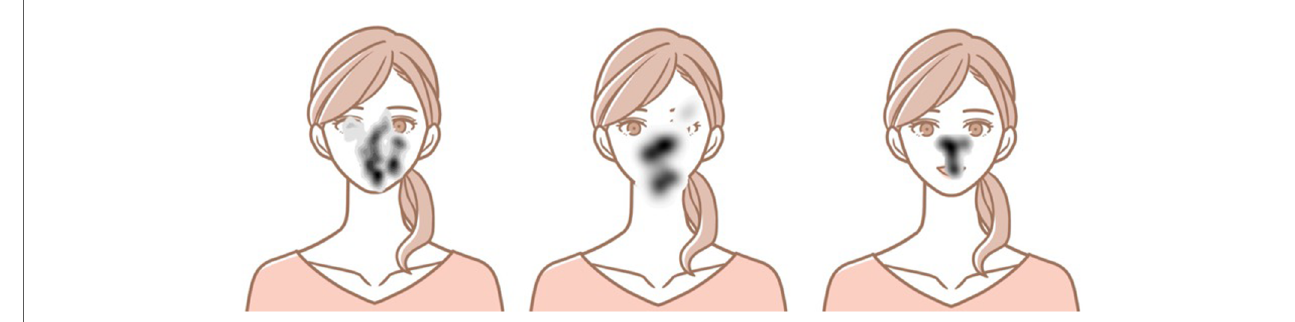
FIGURE 1 Schematic image and typical eye movement patterns. Left: ASD; center: Controls; right: Sz.